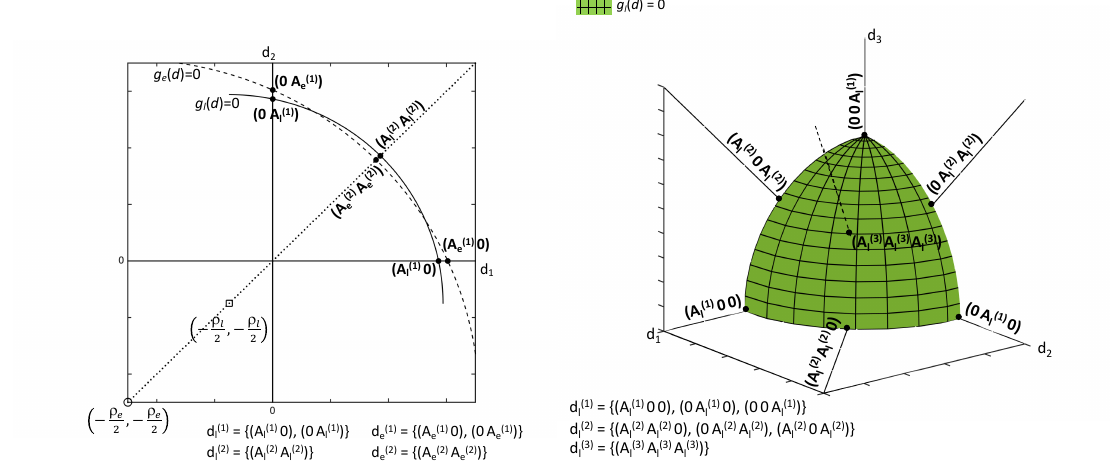
Figure 1. Qualitative geometrical representation illustrating Theorem 2 for n = 2 and n =